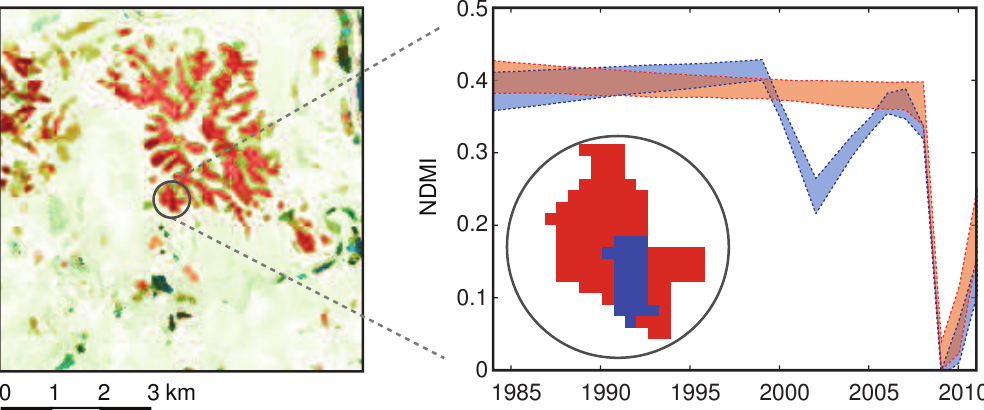
Figure 12. Detail of a changescape patch exhibiting mixed disturbance. Bark beetles attacked the core of the patch (blue) beginning in 1999, which mostly re-greened by 2005, and then burned along with its surrounding area (red) in a 2009